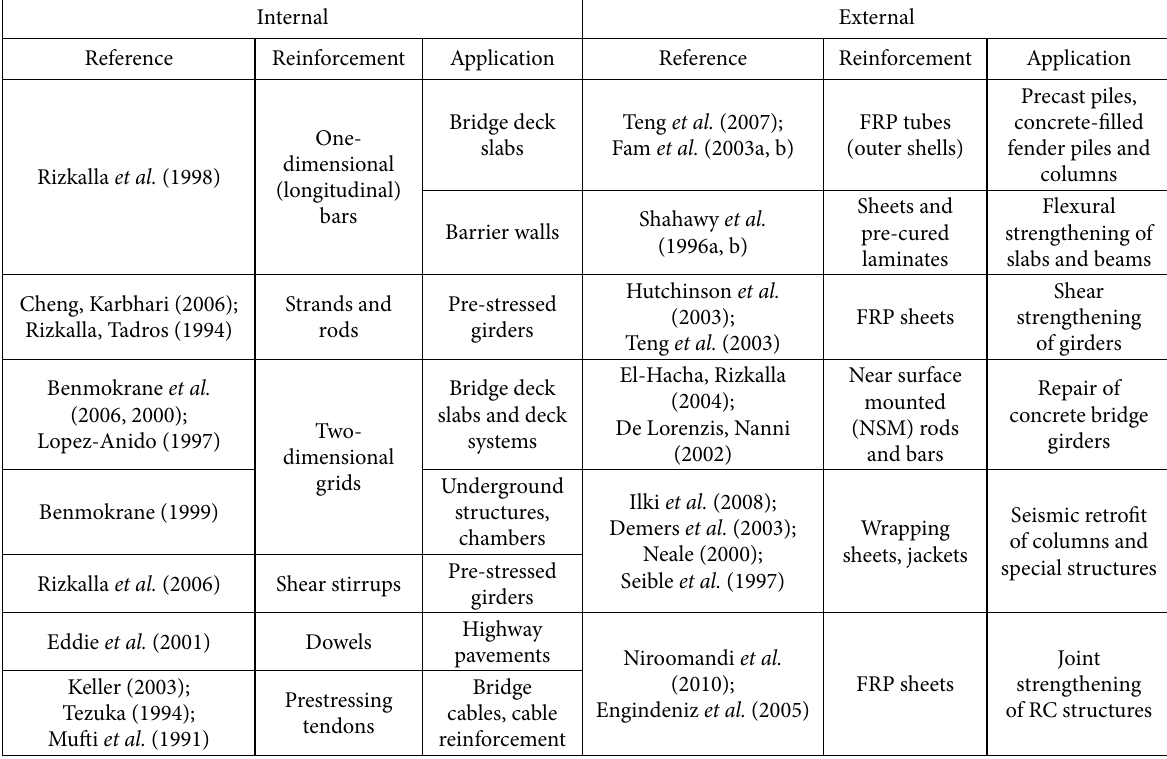
Table 3. Application of internal and external FRP